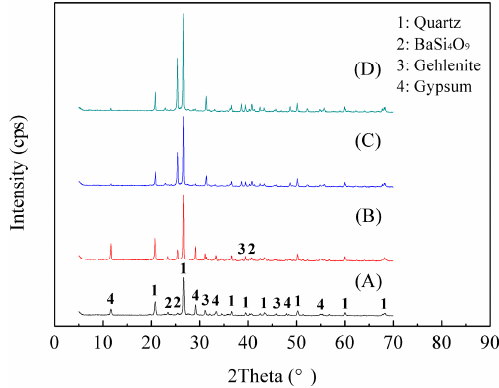
Figure 10. XRD patterns of leaching samples at different leaching temperature. ( A ) Leaching at 60 °C; ( B ) Leaching at 70 °C; ( C ) Leaching at 80 °C; ( D ) Leaching at 95 °C.